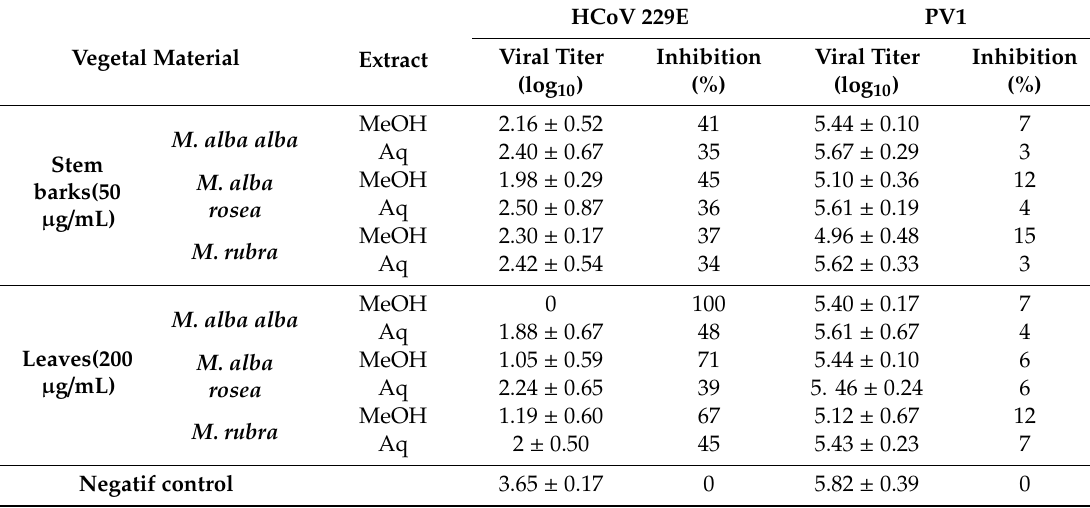
Table 2. Antiviral activities of stem barks and leaves’ aqueous and hydromethanolic extracts on HCoV 229E and